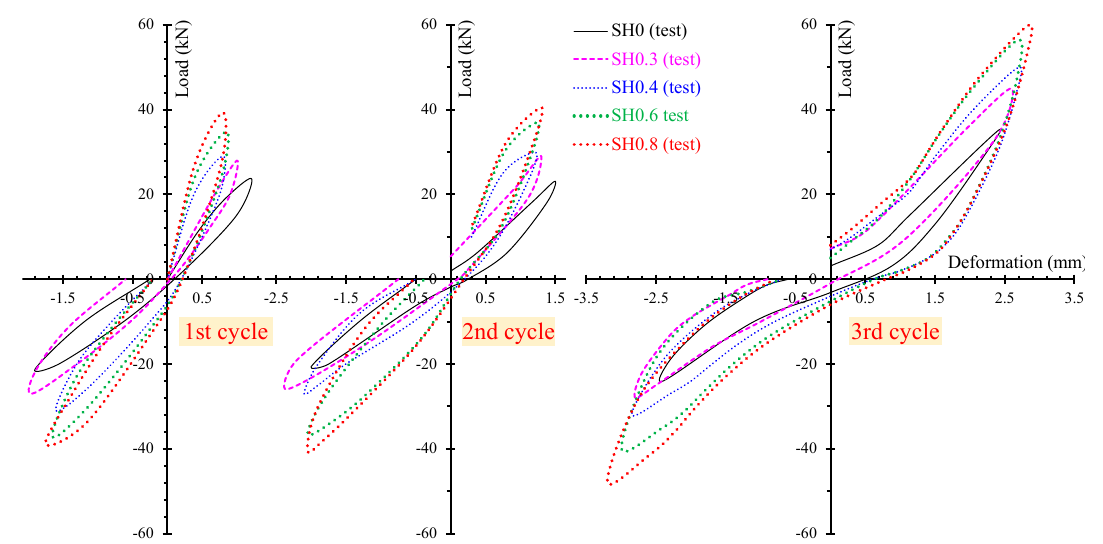
Figure 15. Hysteretic response at each loading cycle of the shear-critical beams without stirrups (group “SH” specimens).